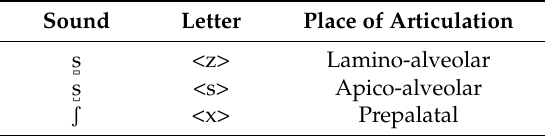
Table 1. Sound, letter, and place of articulation of the three sibilants in Basque (following